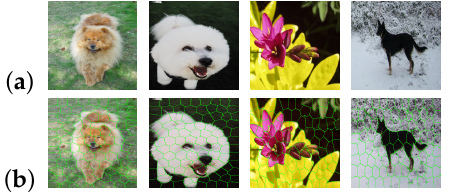
Figure 2. Illustration of SLICO (Simple Linear Iterative Clustering with zero parameter) superpixels bounderies: ( a ) images ; ( b )